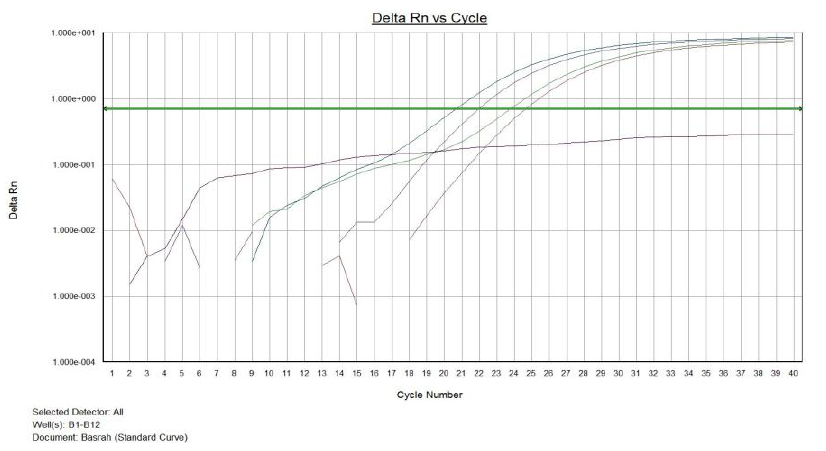
Figure 3: The result of rRT-PCR in four tested samples which show the Logarithmic fluorescence plots versus cycle number resulting from the determination of FMDV